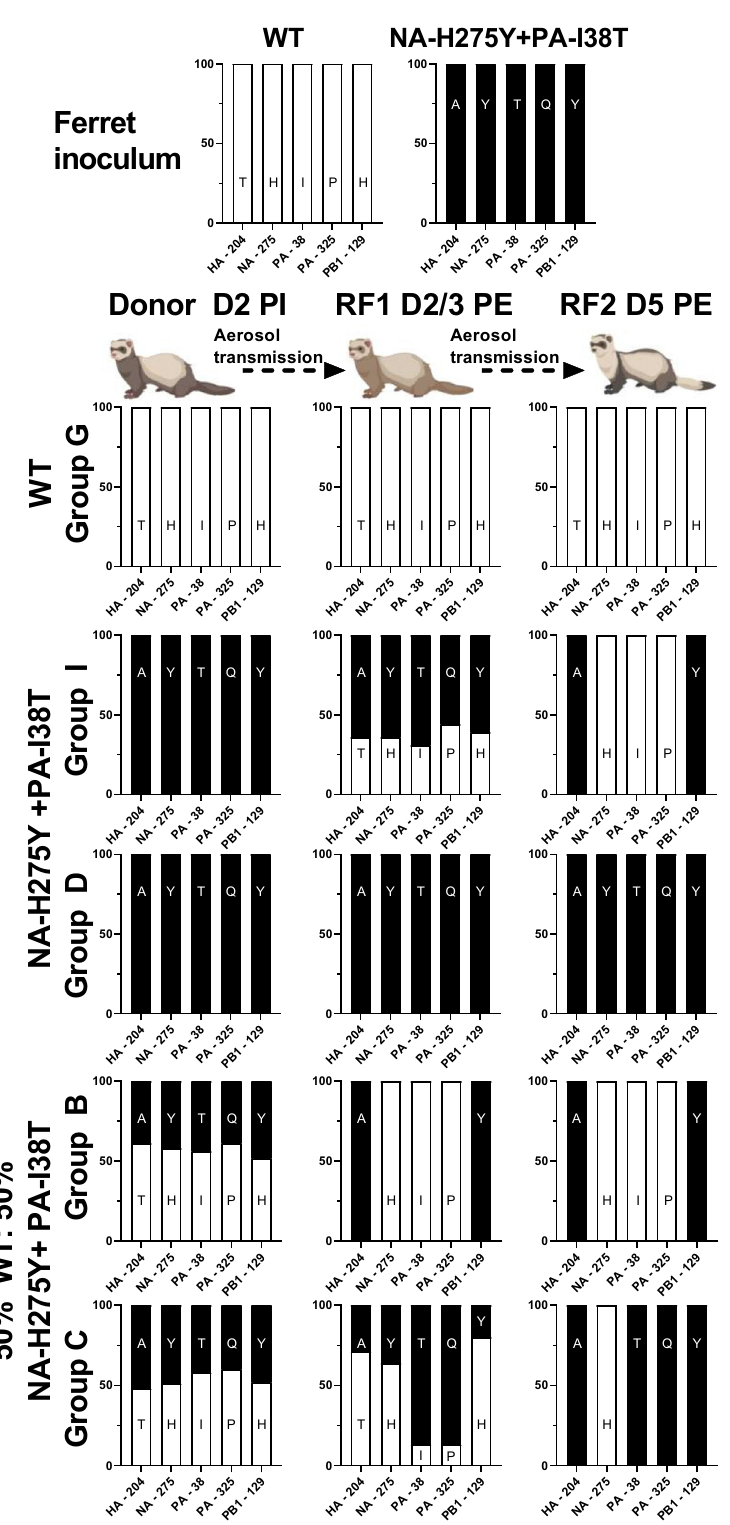
Fig. 5 Summary of whole-genome sequencing on ferret inoculum and nasal wash samples from pure WT, pure NA-H275Y + PA-I38T and 50% WT: 50%NA-H275Y + PA-I38T isolate infected ferrets. Ferret inoculum and nasal wash samples post inoculation/exposure (PI/E) from pure WT, pure NA- H275Y + PA-I38T or 50% WT: 50%NA-H275Y + PA-I38T virus infected ferrets were sequenced using WGS. Five amino acid (AA) changes (across the HA, NA, PA and PB1 genes) distinguished ferret inoculum WT and NA-H275Y + PA-I38T virus genotypes. The bar charts display the proportion of AA codon changes detected by NGS for each sample associated with the WT (white) and NA-H275Y + PA-I38T (black) virus inoculum for each gene loci (along X-axis; HA-294, NA-275, PA-38, PA-325, PB1-129). Percentage frequency of AA codons is determined from variant bases called with a read depth over 1000 and frequency of greater than 5%. Created with